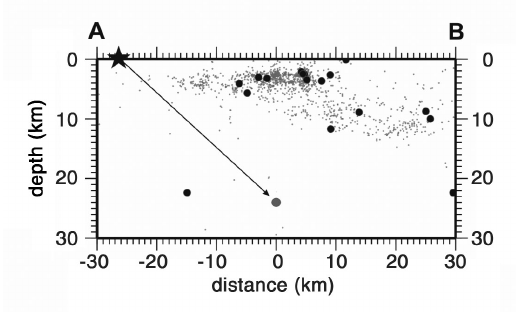
Fig. 7. WNW-ESE section (A-B) of the seismicity plotted in fig. 1. The emphasized local seismic event ( M L = 2.5) occurred beneath the CDC-array at 27 km E from MAC at a depth of 24 km.